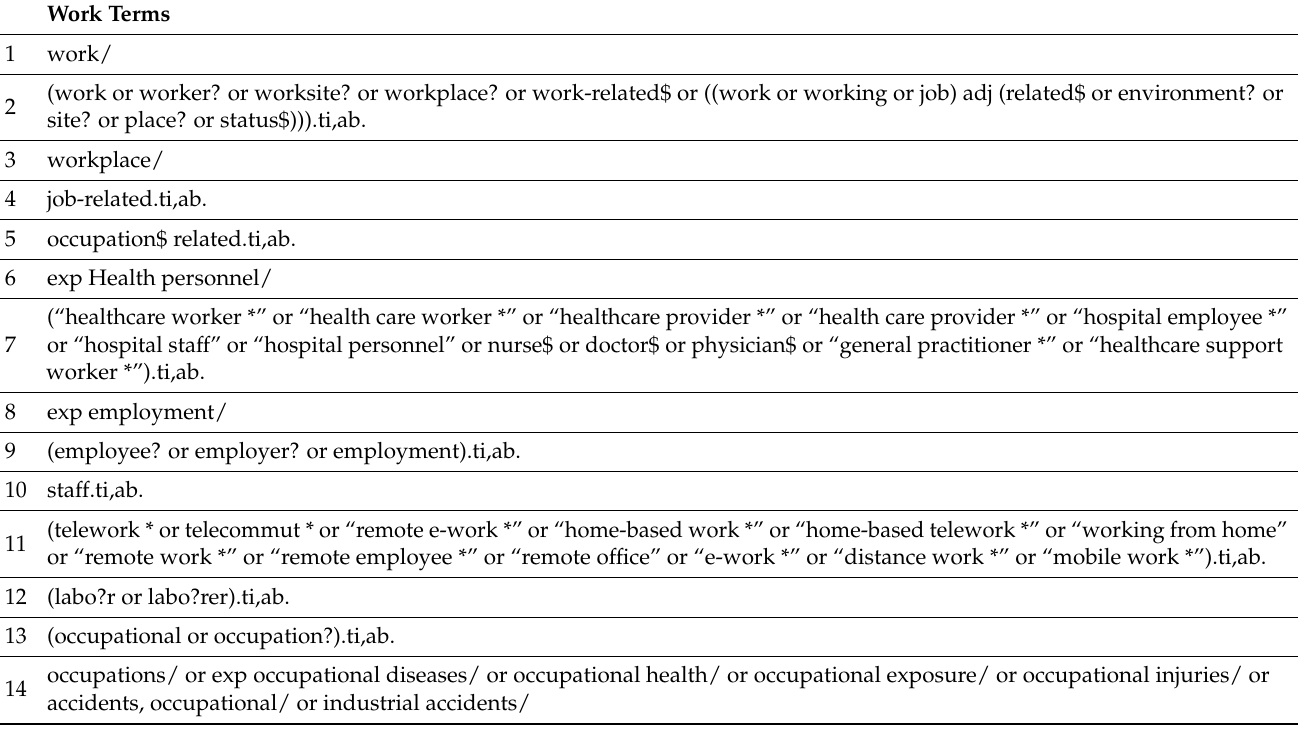
Table A1. Search strategy performed on the MEDLINE, PsychINFO and Embase databases via